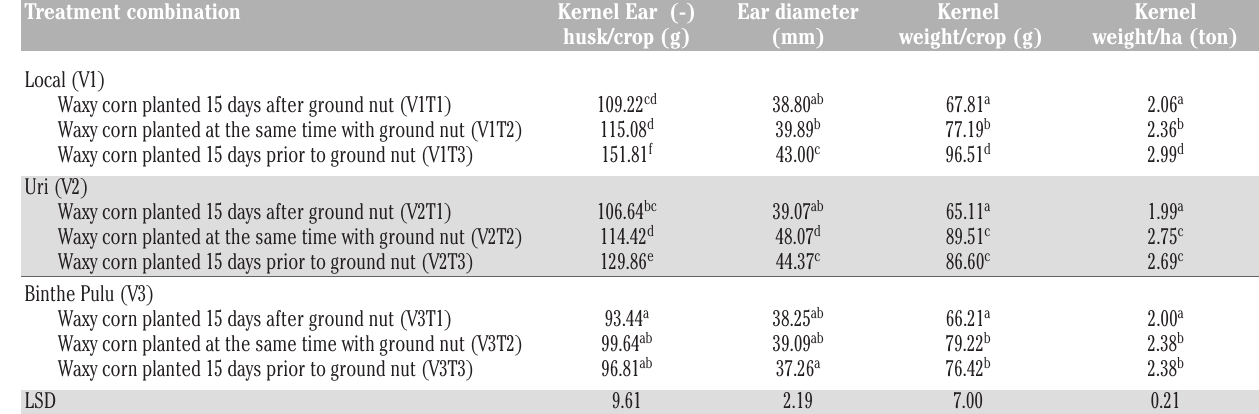
Table 4. Interaction between waxy corn and planting date towards average ear weight without husk, ear diameter, kernel weight per crop, and kernel dry weight (ton ha -1 ) at harvest time (110 hst). Treatment